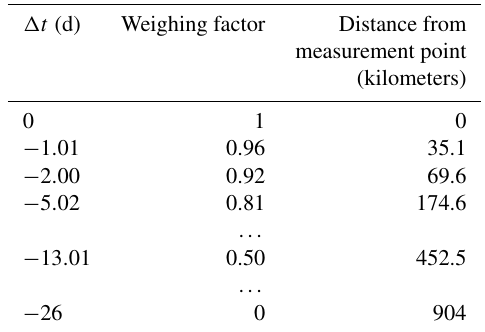
Table 3. Weighing factors for the distance and the resulting (cid:49)t for the monitoring station of Koblenz. (cid:49)t is calculated from distance and flow speed; see Eq. (9). The weighing coefficient is linearly correlated to (cid:49)t